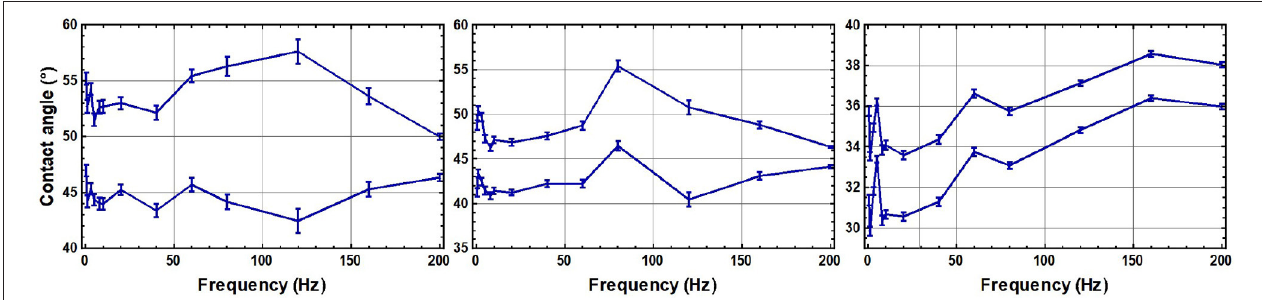
FIGURE 7 | Contact angle as a function of frequency. For each plot, the upper line corresponds to the advancing angle and the lower line corresponds to the receding angle. Left : PEO1. Center : PEO5. Right : PEO8. The difference between advancing and receding angle diminish as the molecular weight is higher.